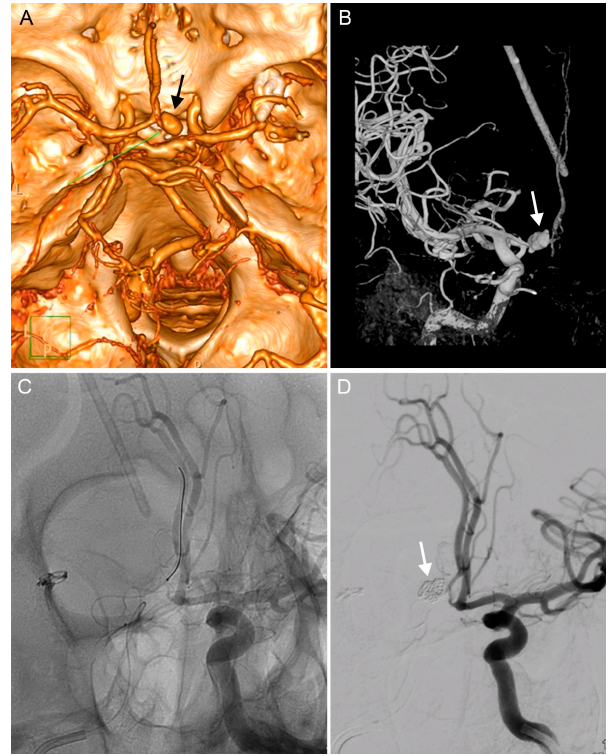
Figure 2. Diagnosis and endovascular treatment of an iatrogenic PSA of the A1 segment of the right anterior cerebral artery (ACA). ( A ). CT angiography showing a PSA of the right A1 segment (arrow). ( B ). The same PSA on a diagnostic digital substraction angiography (DSA, arrow) after implanting a ventriculo-peritoneal (VP) shunt. ( C ). An endovascular intervention for the PSA: a guidewire in the right ACA. ( D ). Angiography showing completed coiling of the PSA and showing patency of both A2 segments. Twenty-two months later, he was readmitted with a severe headache; a CTA was performed and did not show PSA recurrence or a subarachnoid hemorrhage but identified thrombosis of the straight, right sigmoid, right transverse and partial left transverse sinuses. Anticoagulation therapy was initiated and resulted in the recanalization of all sinuses, with the exception of the right transverse sinus. Afterwards, the patient and his family elected surgical clipping of the contralateral mirror MCA aneurysm, which was performed by the original surgeon 11 months later. The final procedure was uncomplicated (Figure 3A,C), and the patient was released with a minor organic psychosyndrome, completely self-dependent, without hemiparesis.